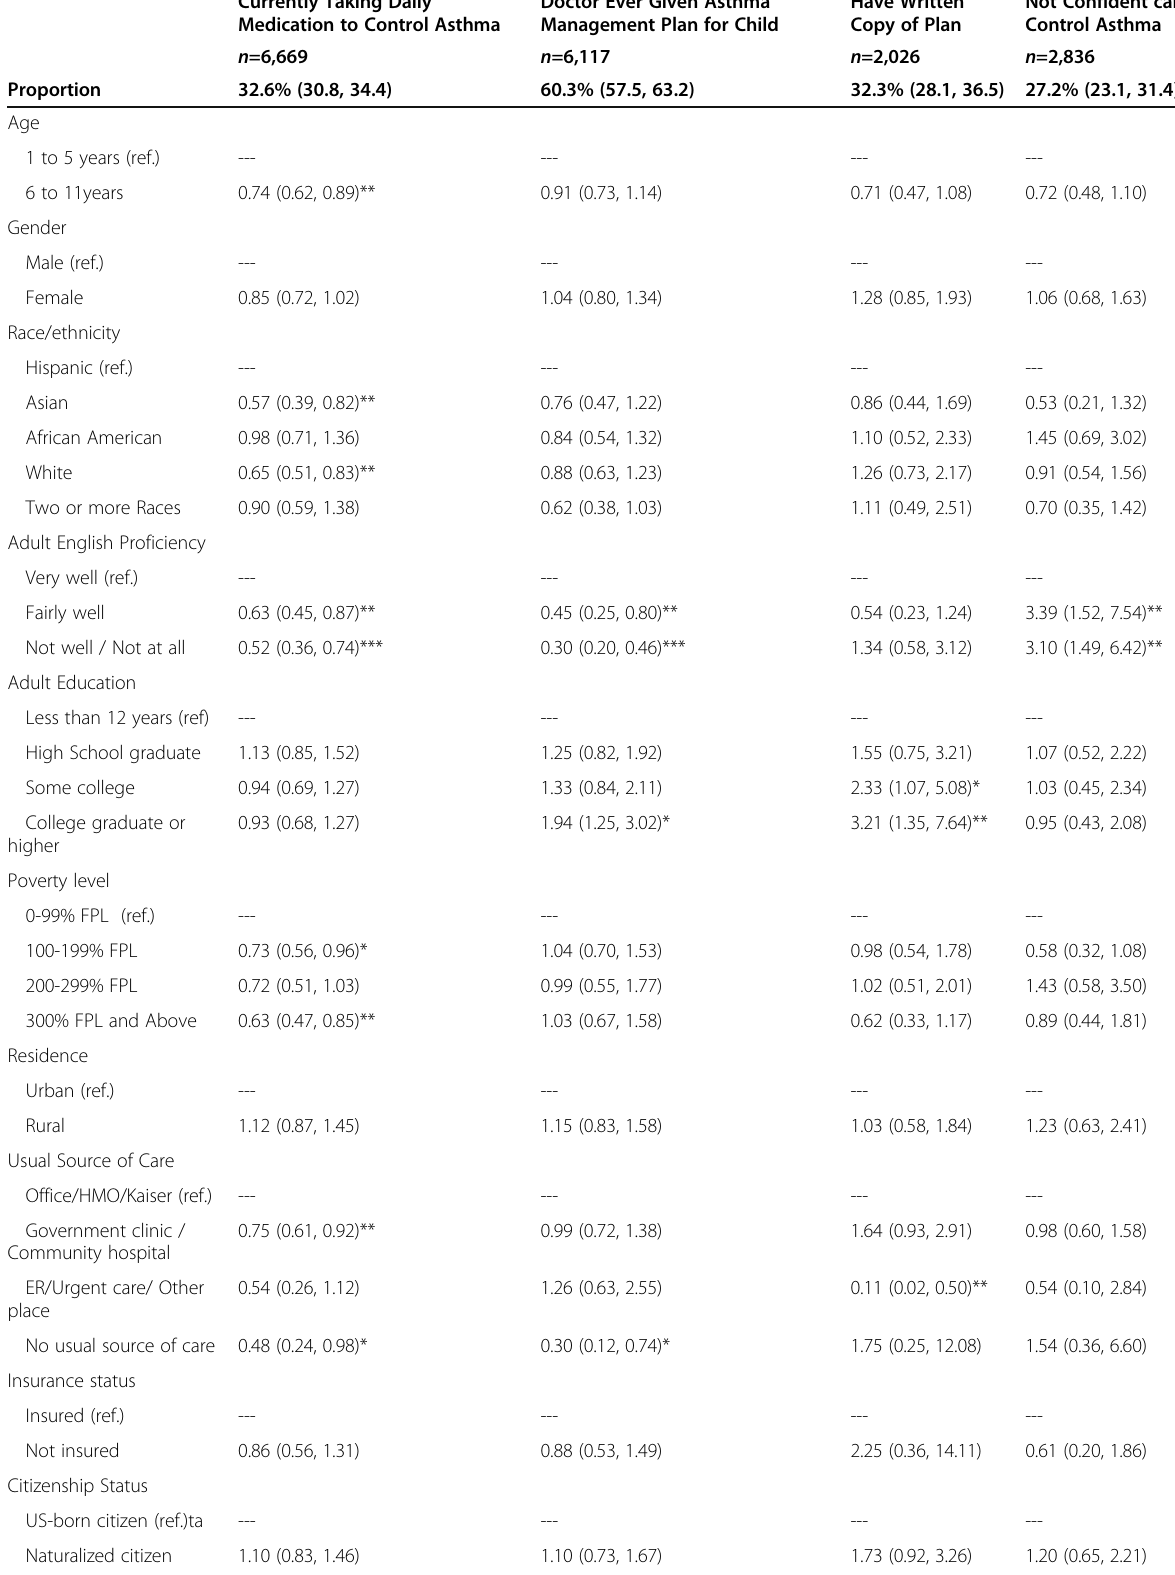
Table 3 Logistic Regression for Asthma